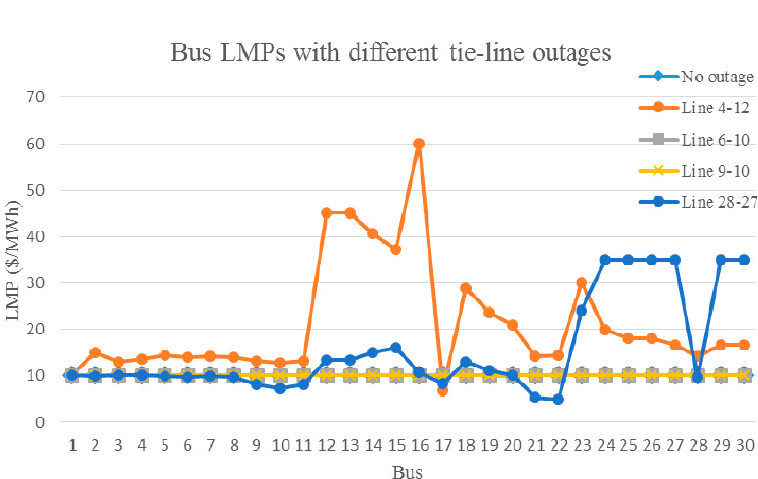
Figure 8. Bus LMPs in IEEE 30 ‐ bus system with different tie ‐ line outages.